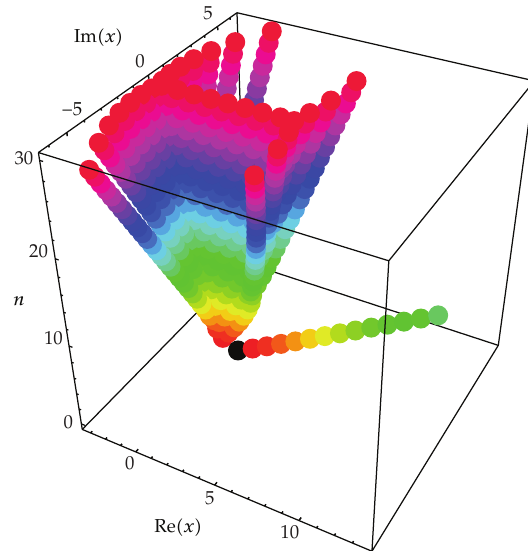
Figure 14: Stacks of zeros G n, 1 / 3 (cid:2) x (cid:3) for 1 ≤ n ≤ 30.